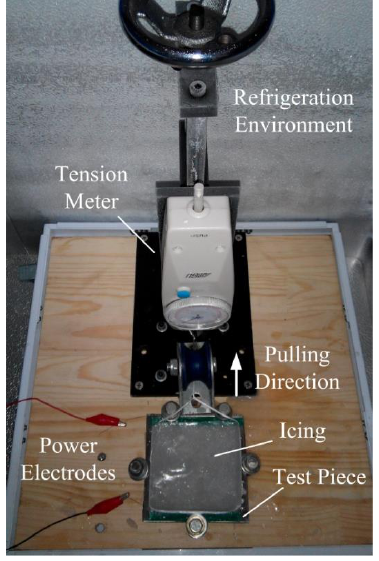
Figure 2. Photograph of deicing experiment device.